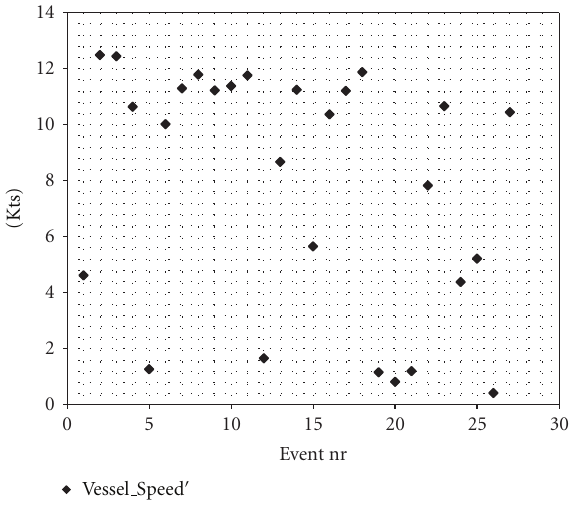
Figure 24: Vessel speed during the events—starboard unit.